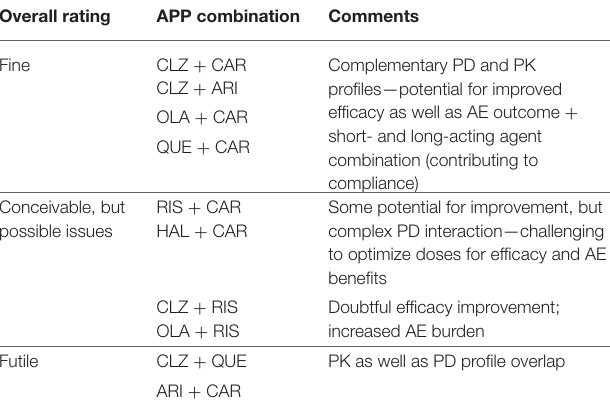
TABLE 4 | Summary of theoretical pharmacological usefulness of APP examples discussed. Overall